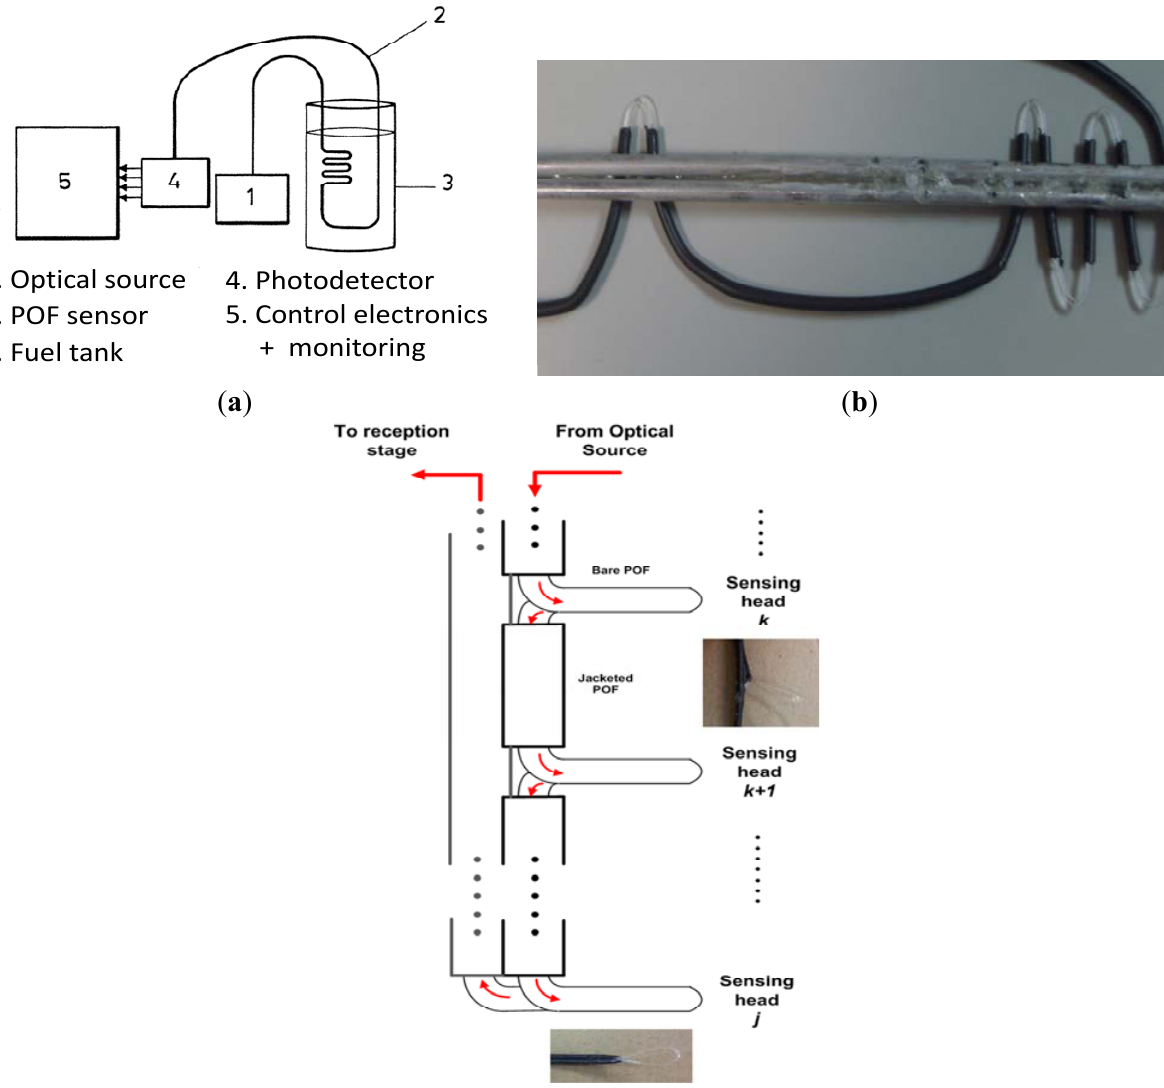
Figure 2. ( a ) Block diagram of the fuel level measuring system; ( b ) Photograph of a gauge-shaped POF-based fiber-optic sensor prototype for fuel level measurements; ( c ) Block diagram of the twist-shape POF fiber-optic sensor